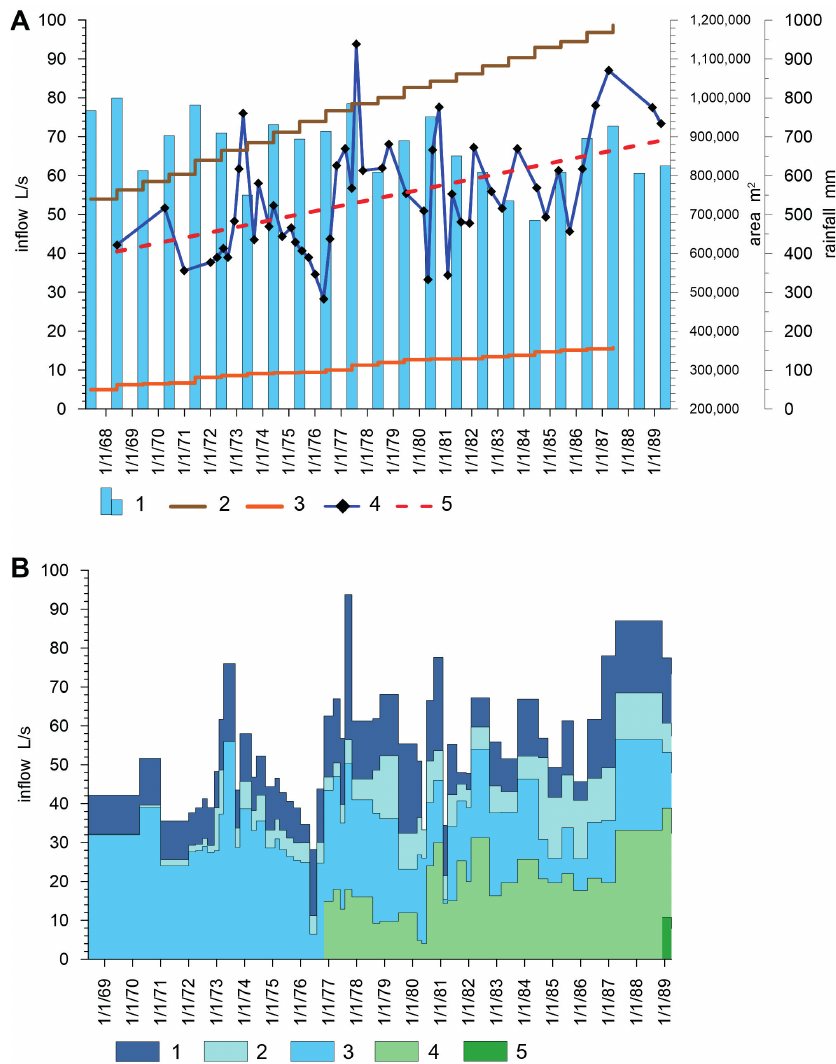
Figure 4. The inflow to the mine workings of the “Słupiec” mining area (Adapted from Chudy [39]): ( A ) on the background of selected elements: 1—precipitation (Nowa Ruda Słupiec monitoring station); 2—developing of accumulated mining area; 3—developing of mining area; 4—total inflow to mine workings; 5—trend line of water inflows to mine workings; ( B ) to the excavation on the particular mining levels: 1. +170; 2. +50; 3. − 110; 4. − 270; 5. −